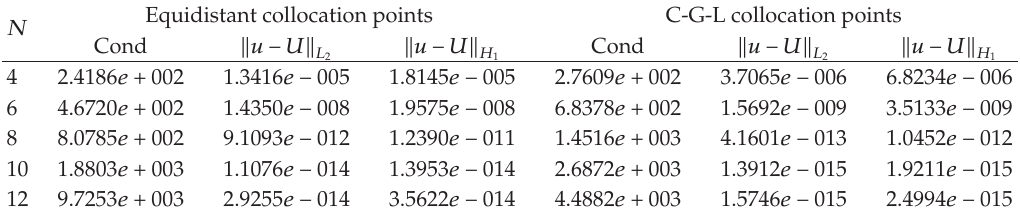
(cid:4) 10, β (cid:4) 100 (cid:6) . 1 2